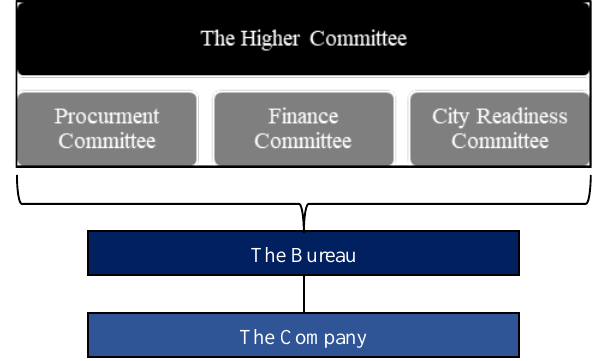
Figure 1 . Dubai Expo 2020 Governance Model (Dubai Expo